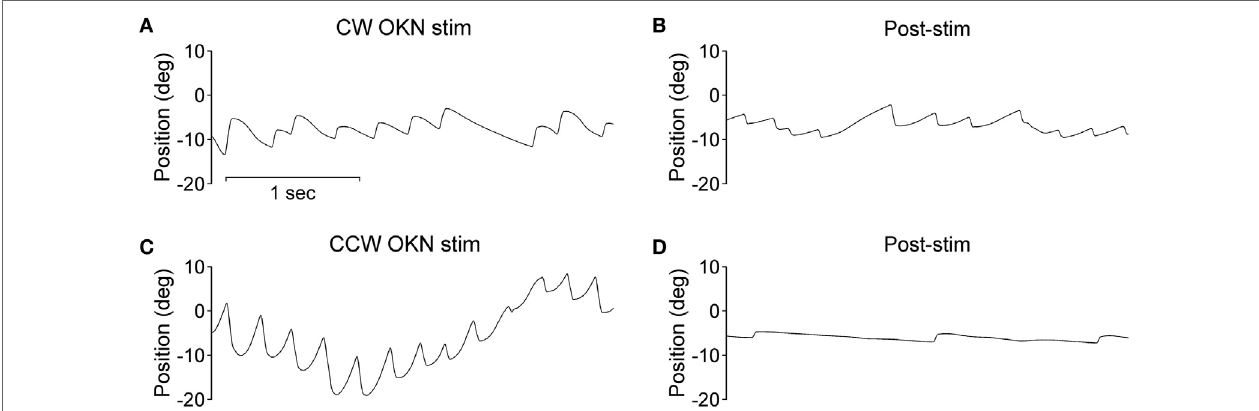
FigUre 3 | Optokinetic nystagmus (OKN) and afternystagmus of the infantile nystagmus syndrome patient. Plots on the left demonstrate eye position traces during optokinetic stimulation in (a) CW (clockwise) and (C) CCW (counterclockwise) directions. Plots on the right demonstrate eye position traces in darkness subsequent to the 10-min optokinetic stimulations in (B) CW (clockwise) and (d) CCW (counterclockwise) directions. OKN stim, optokinetic stimulation phase; post-stim, post-stimulation